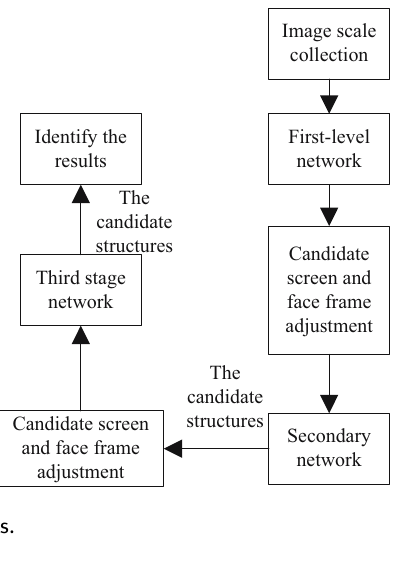
Figure 1: Automatic identi fi cation process.